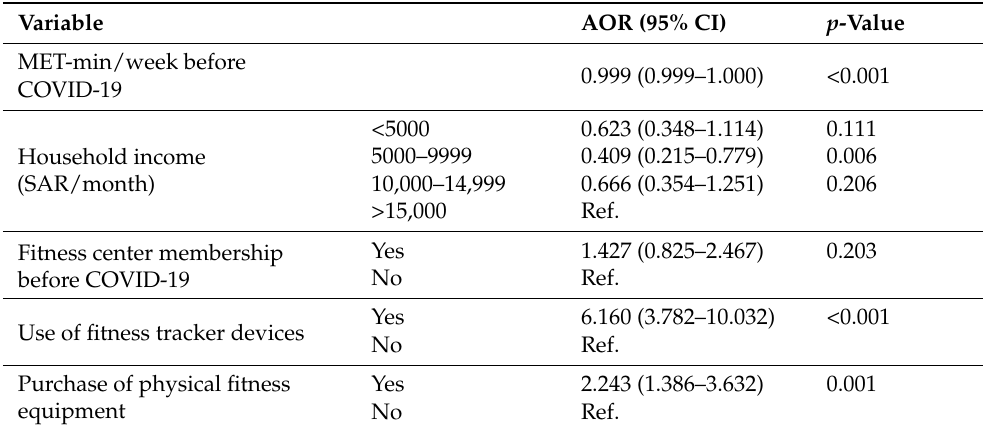
Table 3. The results of multinomial logistic regression predicting maintaining of the PA level during the